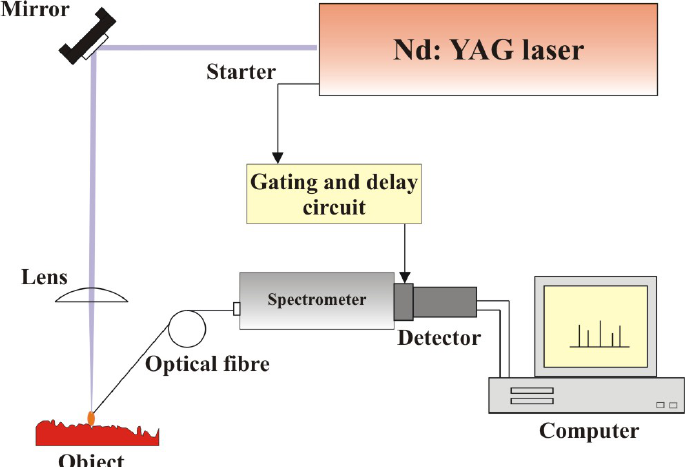
Figure 5. Block scheme of LIBS experimental